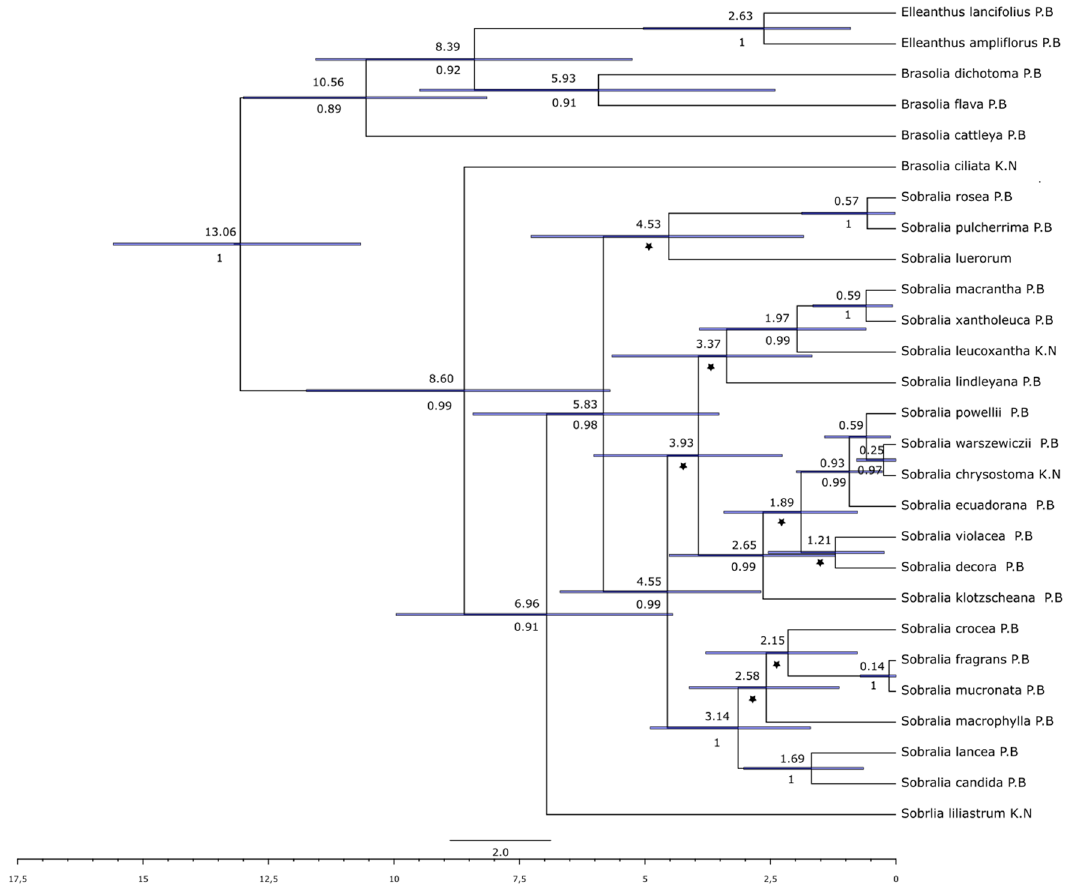
Figure 1. Maximum Clade Credibility tree for Sobralia and related genera, Bayesian inference based on nuclear ITS using Beast. The divergence times for each clade were estimated by relaxed molecular clock analysis with Yule model of speciation. The calibration points were designated in the result of phylogenetic analysis of Sobralieae tribe (see supplementary material Fig. S1). The values above nodes present the divergence time, those below the branches are posterior probabilities (PP ≥ 0.9), the values of PP < 0.9 are indicated as a star.